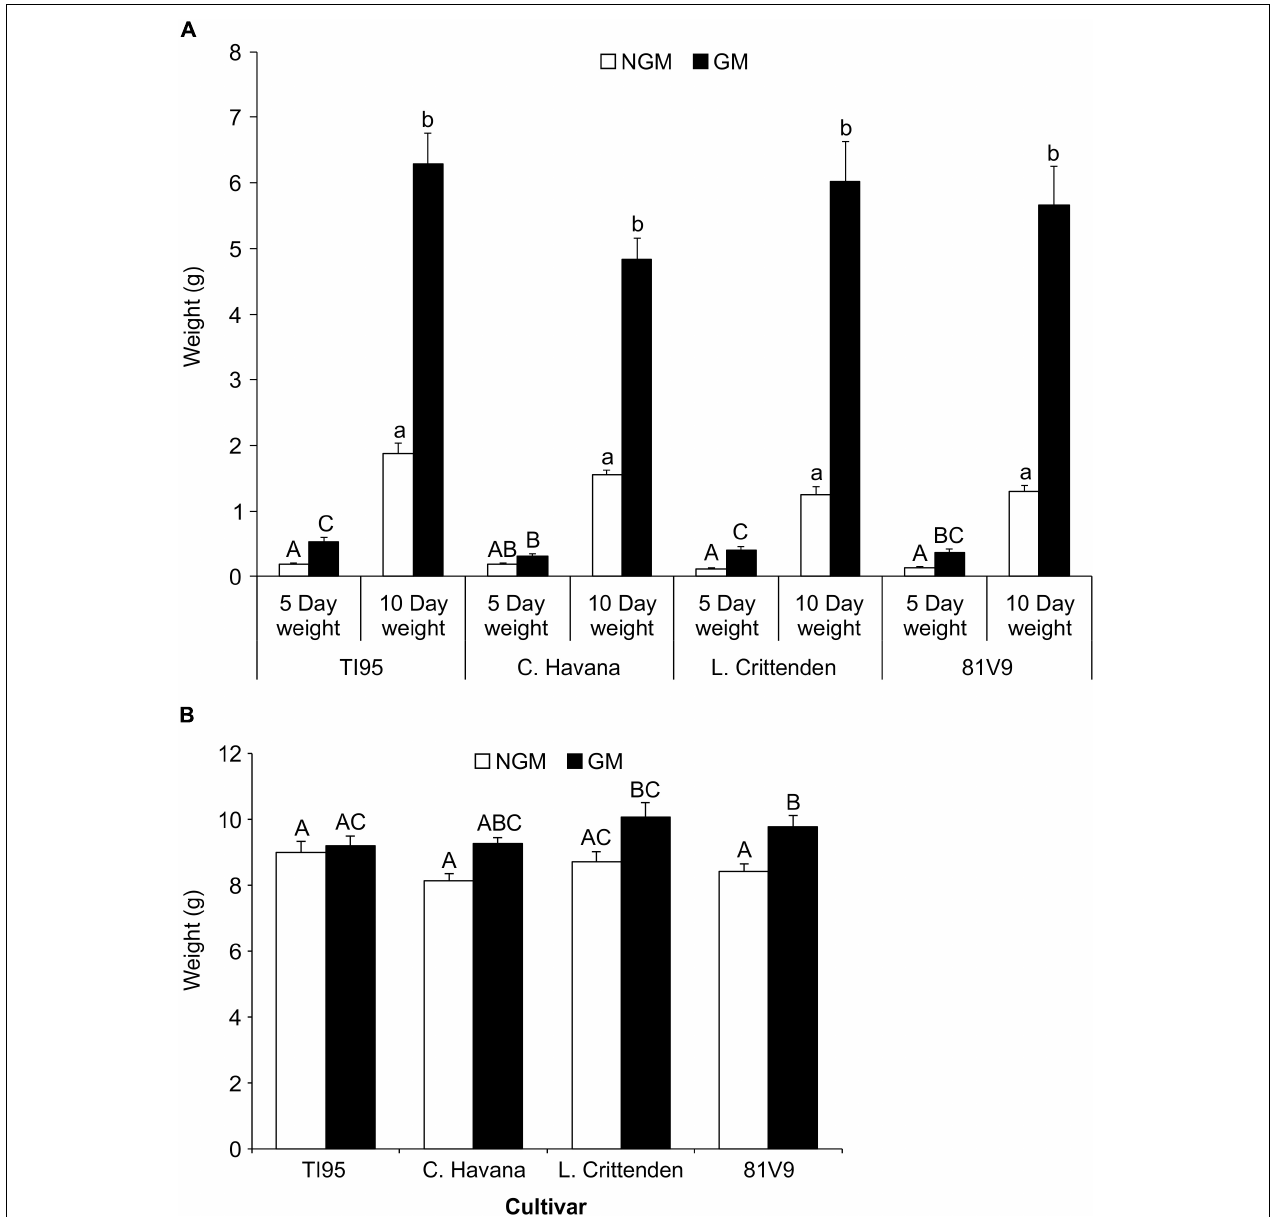
FIGURE 4 | Tobacco hornworm larvae gain more weight on greenhouse-grown transgenic lines when younger, but even-out by the pre-pupal stage. Mean larval weights ± S.E. of tobacco hornworm larvae fed on greenhouse grown, non-transgenic and transgenic tobacco cultivars ( N = 20 larvae/cultivar). (A) 5 and 10 days old larvae and (B) pre-pupal larvae (after approximately 20 days). Bars with the same uppercase (5 days weights) or lowercase (10 days weights) letter in (A) are not statistically different, while bars with the same uppercase letter in (B) indicates no statistical difference (2-way ANOVA, Tukey’s pairwise comparison, P < 0.05).